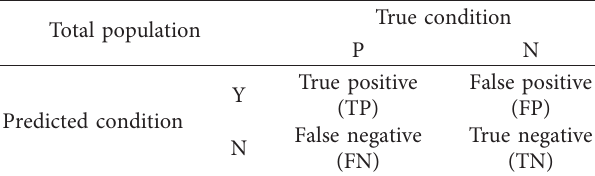
Table 2: Confusion matrix.